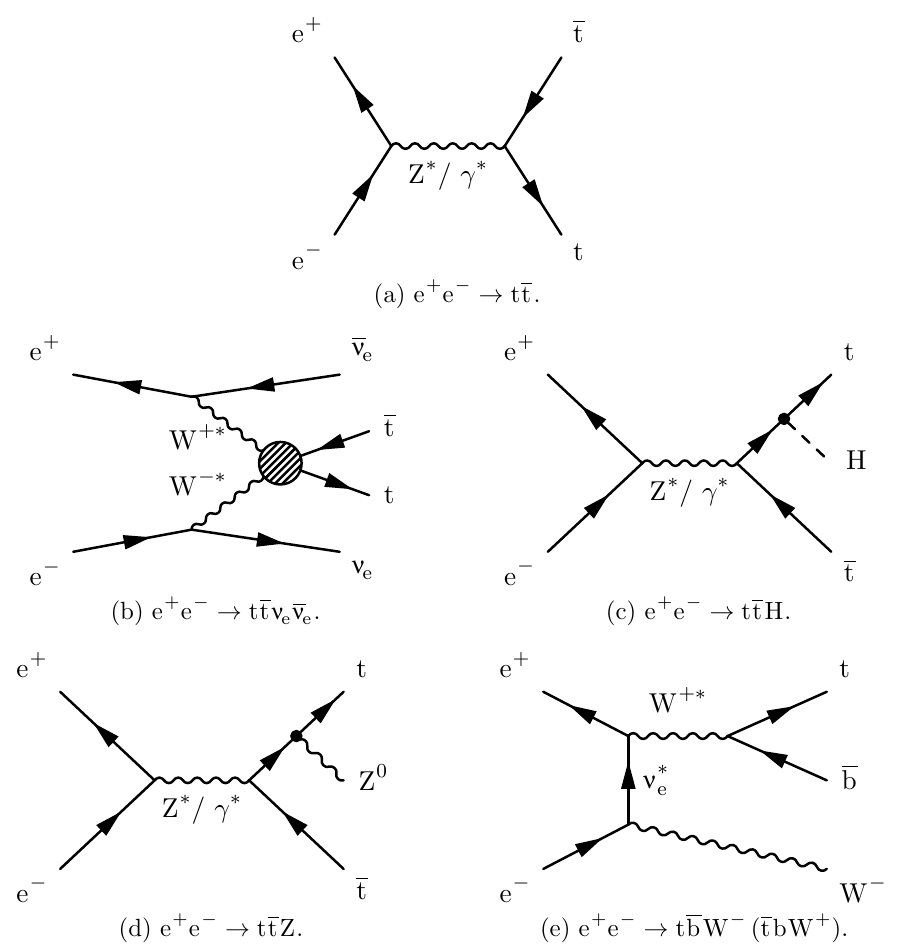
Figure 4. Representative diagrams for top-quark production processes relevant at CLIC; (a) tt, (b) tt n , (c) ttH, (d) ttZ, (e) single-top. The blob in (cid:12)gure 4b represents the complete amplitude e n e of the W + W (cid:0) ! tt Feynman diagram, including potential new physics